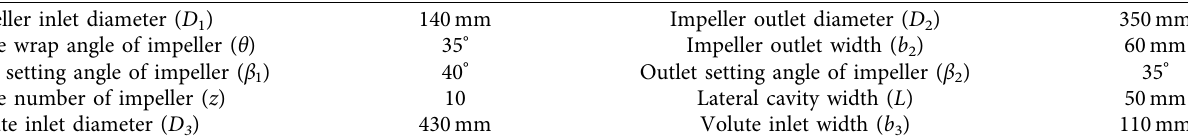
Table 1: Parameters of impeller and volute.